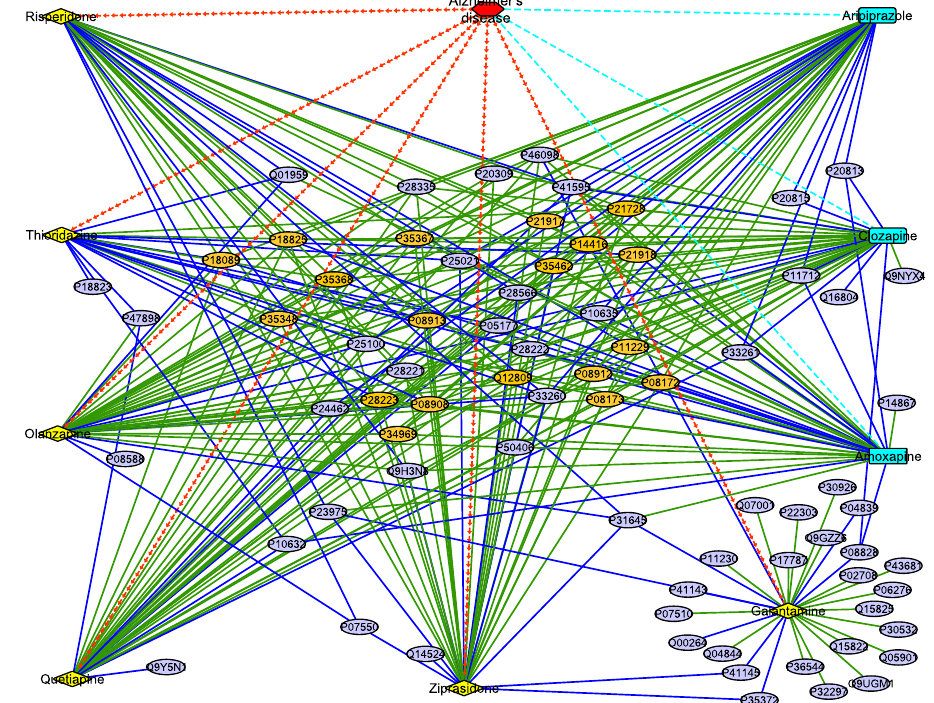
Figure 10. New clues of the treatment of Alzheimer’s disease. Red hexagon denotes Alzheimer’s disease, yellow diamonds denote known drugs of Alzheimer’s disease, azure rectangles denote predicted new clues of treatment of Alzheimer’s disease. Green solid lines denote known DTIs, blue solid lines denote predicted DTIs, red separate arrow lines denote the associations between Alzheimer’s disease and known drugs, azure dash lines denote the associations between Alzheimer’s disease and new clues of